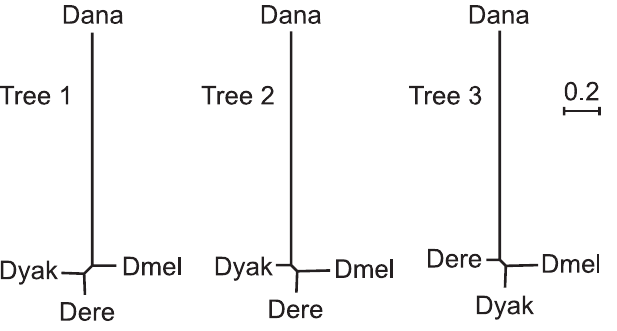
Figure 4. Median Synonymous Trees Median synonymous branch length trees derived from the genes supporting each of the three trees are drawn to the same scale. The branch spanning the two speciation events is quite short for all trees. DOI: